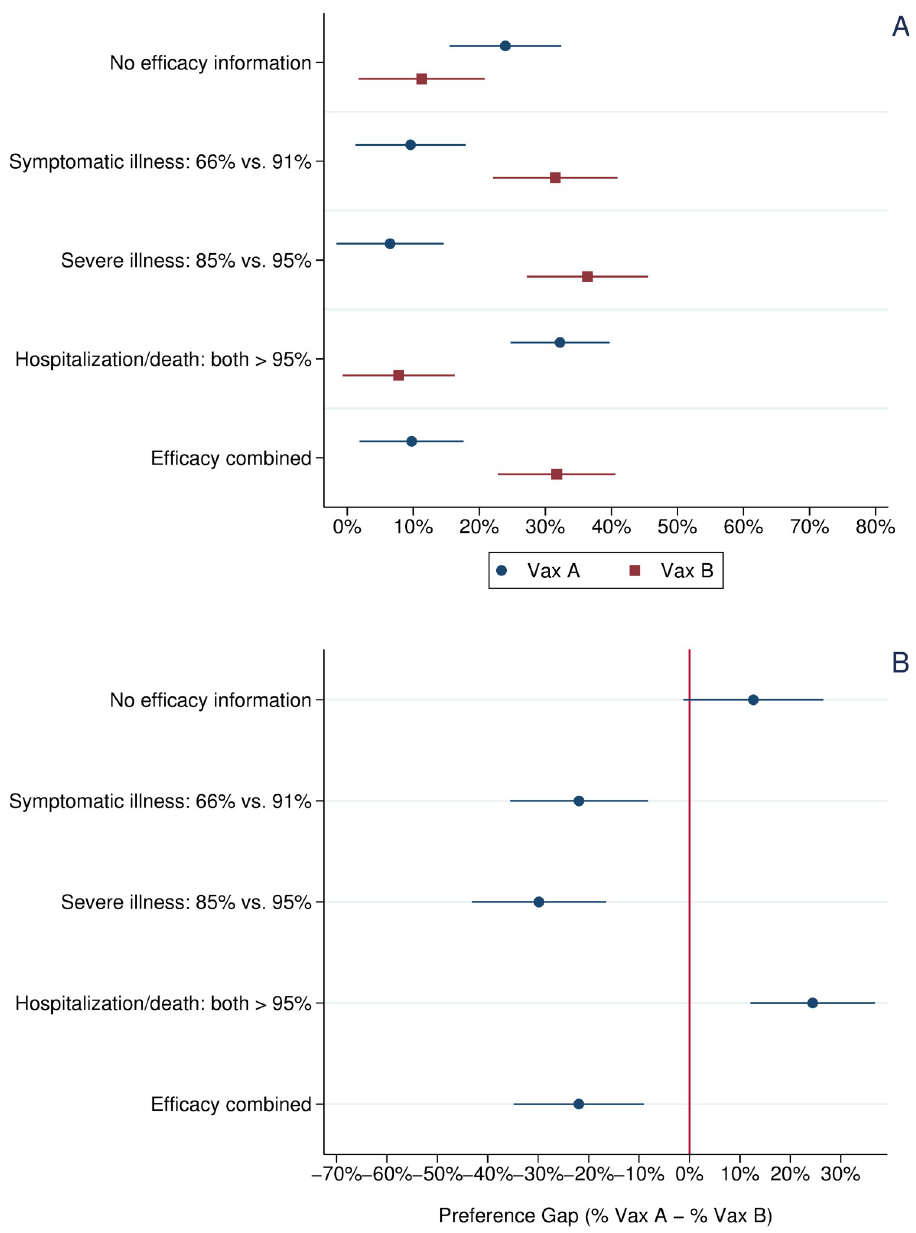
Fig 2. Vaccine choice and preference gap across experimental treatments, unvaccinated respondents. Note : Panel A: Circles indicate the percentage choosing Vaccine A, a one-shot, viral vector vaccine with efficacy data mirroring that reported in the Janssen vaccine trials. Squares indicate the percentage choosing Vaccine B, a two-shot, mRNA vaccine with efficacy data mirroring that reported in the Pfizer vaccine trials. Panel B: Circles indicate the preference gap between Vaccine A and Vaccine B. Horizontal bars present 95% confidence intervals about each mean